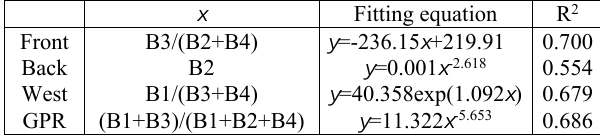
Table 3. The Chl-a regression models of GPR channels based on GF-1 PMS band